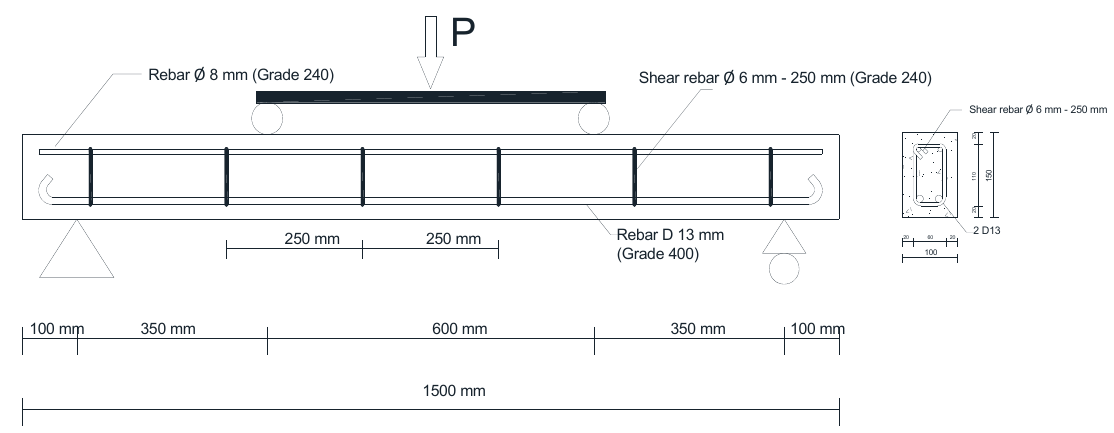
Figure 1. Specimen detail.